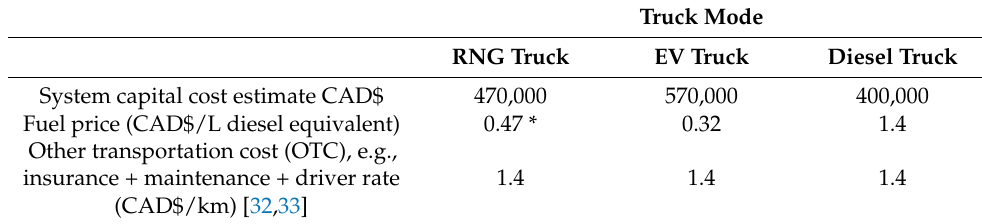
Table 4. The summary of truck modes and associated